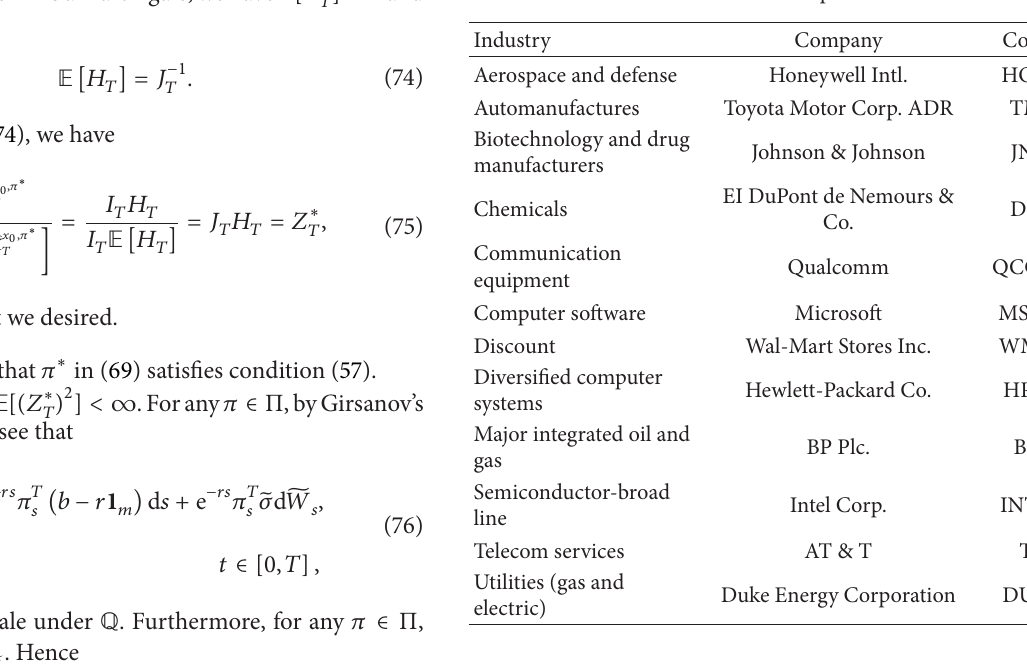
Table 1: Stocks in a complete